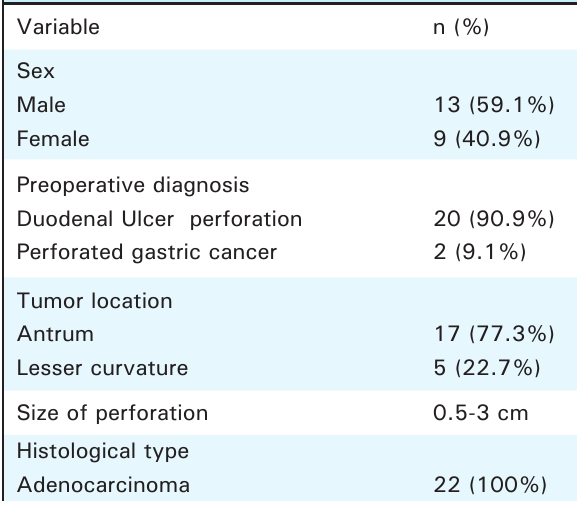
Table 1. Clinicopathological feature of 22 patients with perforated gastric